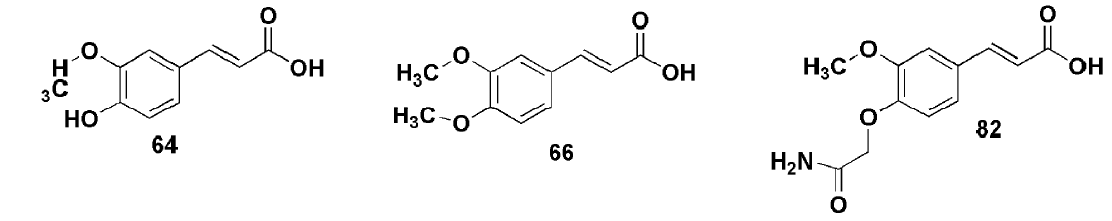
Figure 20. Chemical structures of compounds 64 , 66 and 82 [57,58].